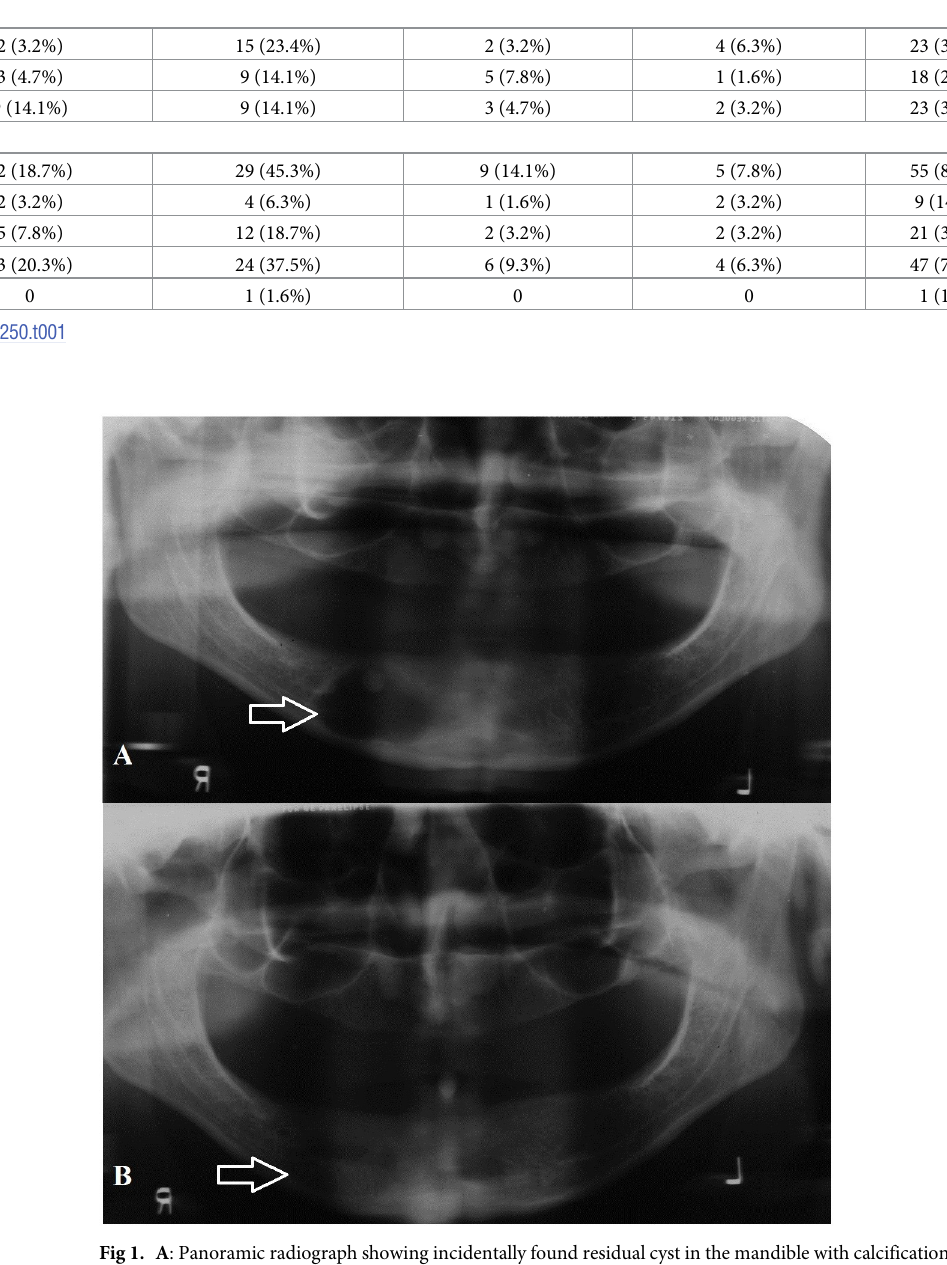
Fig 1. A : Panoramic radiograph showing incidentally found residual cyst in the mandible with calcification. B : Two year post-operative radiograph of same patient showing bone regeneration in the defect.